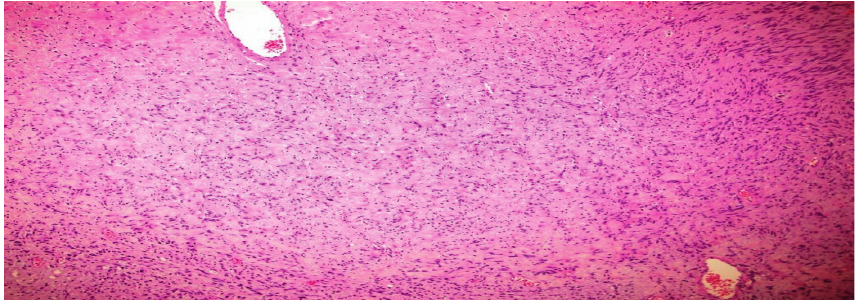
Figure 5: Schwannoma hypocellular areas (Antoni (B))